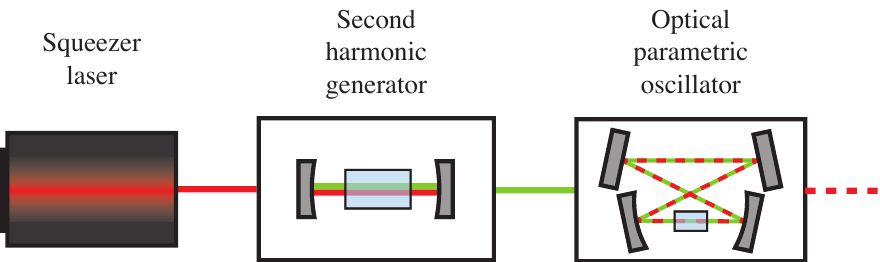
Figure 4. Simplified schematic for squeezed light generation. Red lines indicate 1064 nm beams, green lines are 532 nm, dashed line is squeezed light. The squeezer laser pumps a second harmonic generator which creates the 532 nm light which in turn pumps an optical parametric